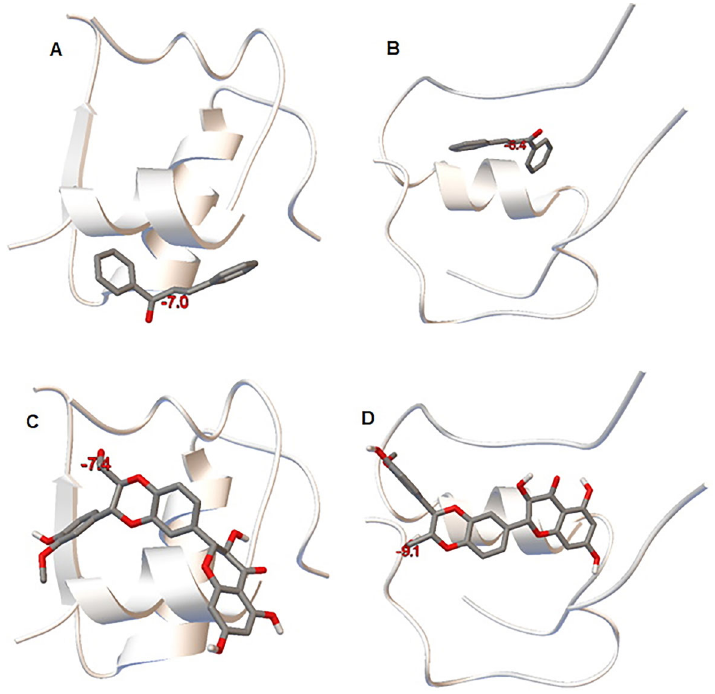
Figure 12. 3D representations of trans- chalcone interactions with ( A ) native and ( B ) denatured insulin and 3D representations of silibinin interactions with ( C ) native and ( D ) denatured